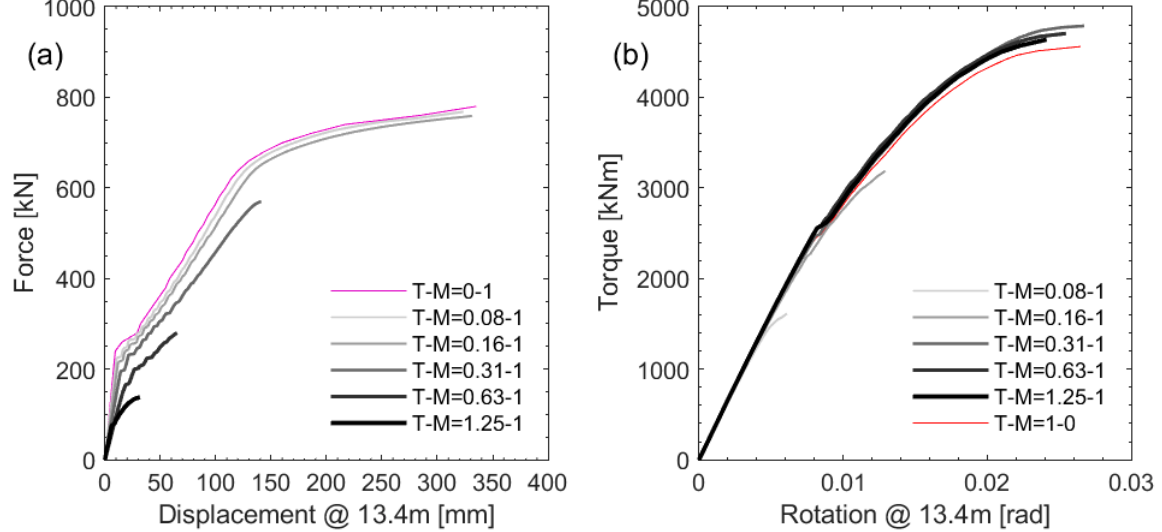
Figure 7. Results from the static pushover analysis performed on the RC U-shaped core wall modelled in SeismoStruct using the beam-truss modelling approach regarding ( a ) force-displacement and ( b ) torque-rotation. Different torque-to-bending-moment (T-M) ratios were used in these analyses.